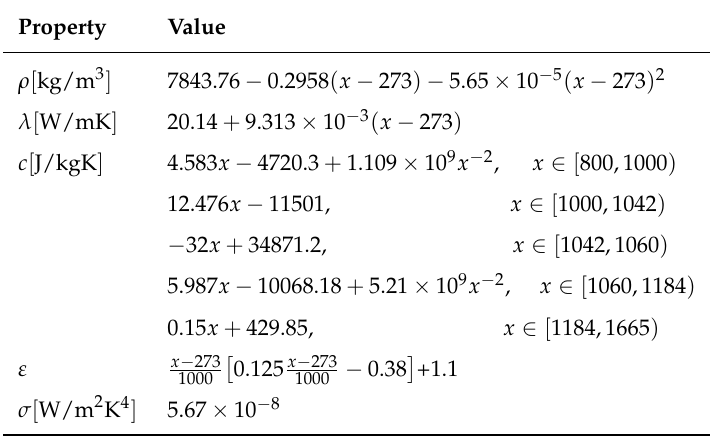
Table 2. Thermal properties of the carbon steels used in this study